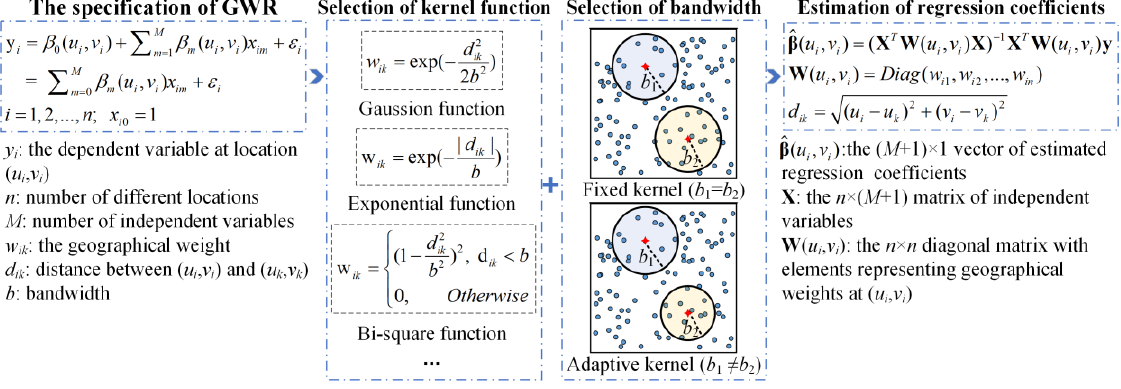
Figure 14. Scheme of GWR